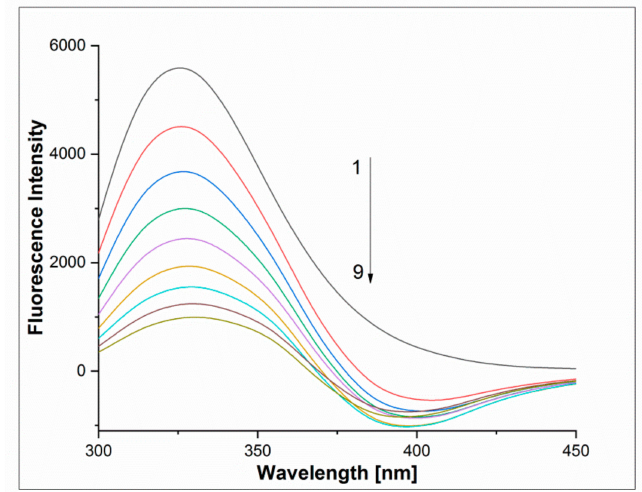
Figure 5. Fluorescence emission spectra of apo-Tf - 3 systems under physiological conditions (Phosphate-Bu ff ered Saline-PBS, pH = 7.40, T = 310K), λ ex = 280 nm, C apo-Tf = 2 · 10 − 6